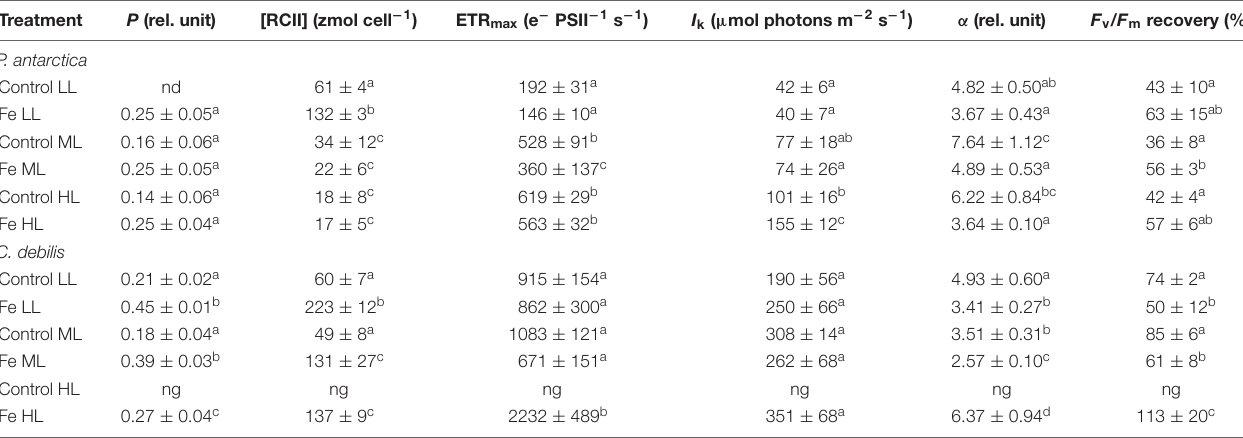
TABLE 2 | Energy transfers between PSII units (i.e., connectivity, P ), cellular concentrations of functional photosystem II reaction centers ([RCII]), maximum electron transport rates (ETR max ), minimum saturating irradiances ( I K ), maximum light utilization efficiencies ( α ) and F v / F m recovery were determined for P. antarctica and C. debilis acclimated to control or Fe-enriched conditions combined with low (LL), medium (ML) or high light (HL). Treatment P (rel. unit) [RCII] (zmol cell − 1